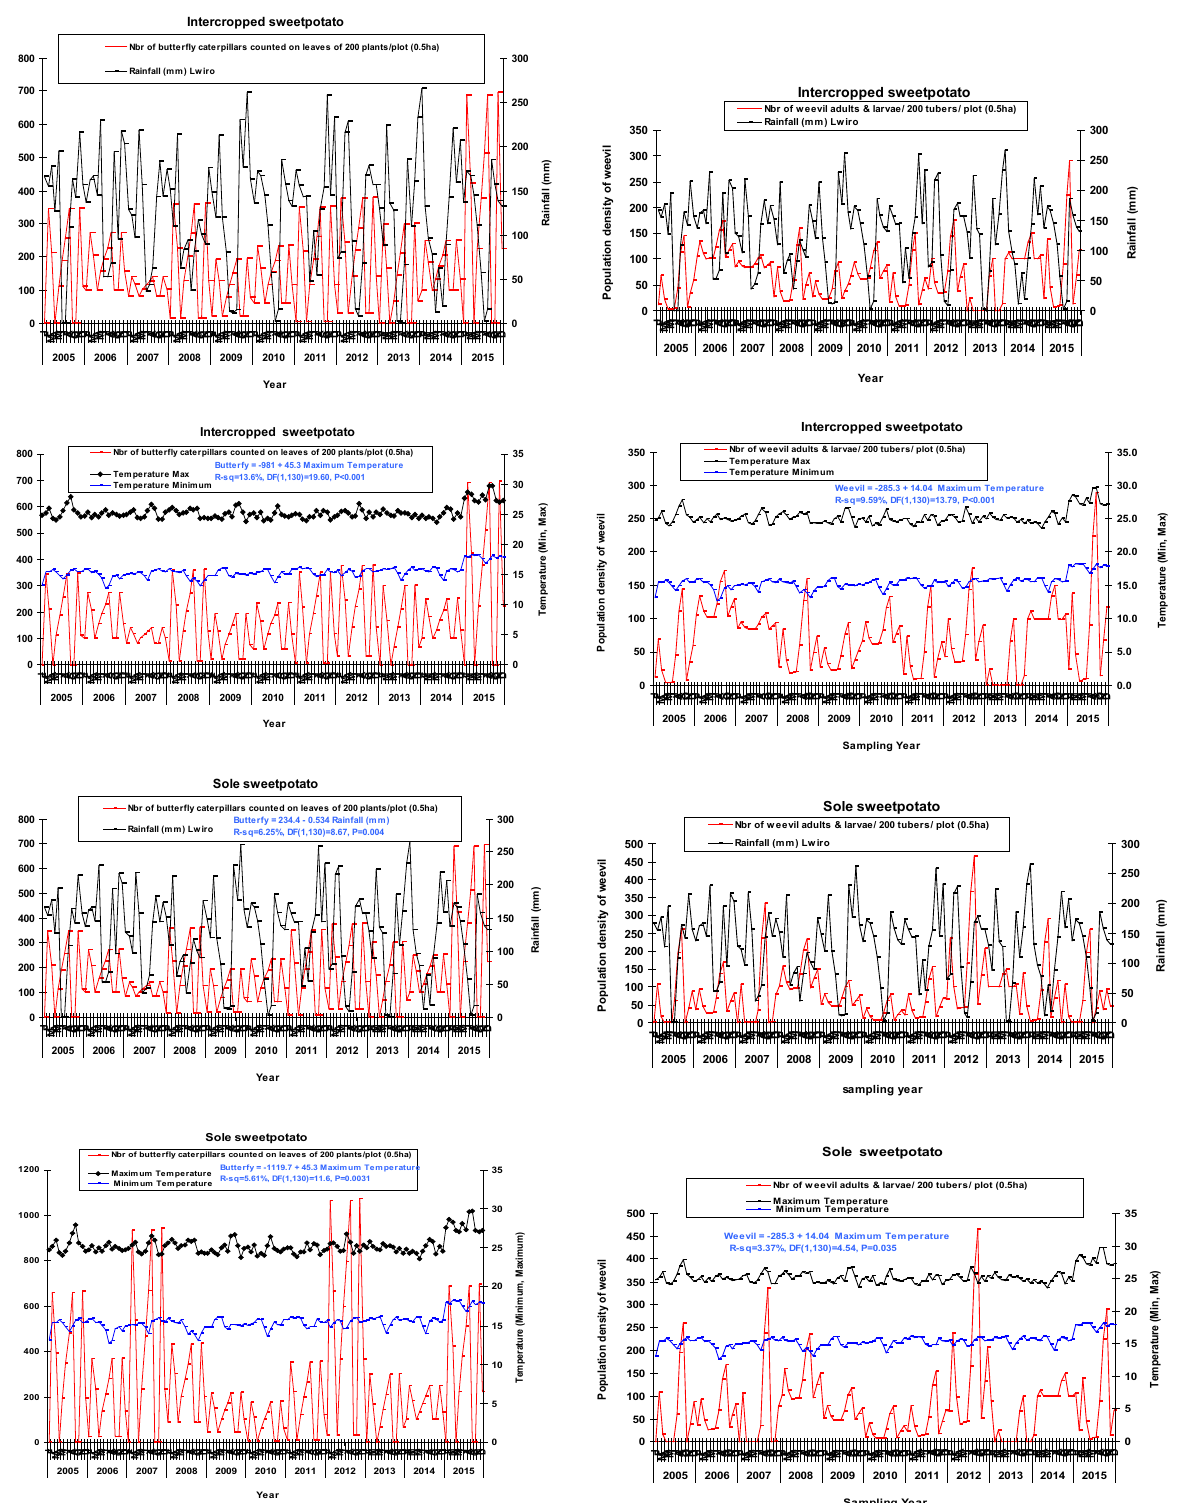
Figure 5: Fluctuation of the population density of sweet potato weevil (Cylas spp) pest in relationship with variability in climatic factors (rainfall, temperature) under intercropping and mono-crop- ping systems in Kivu Province, eastern